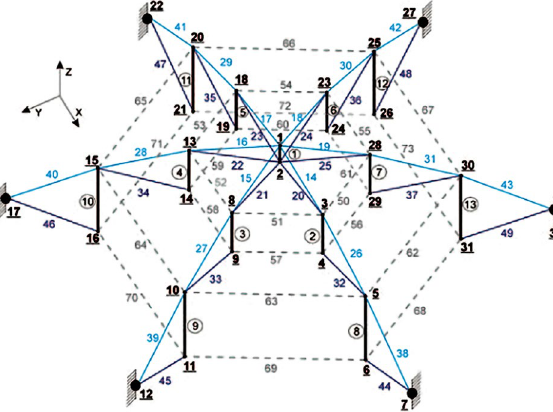
Fig. 6. The tensegrity dome of a Geiger